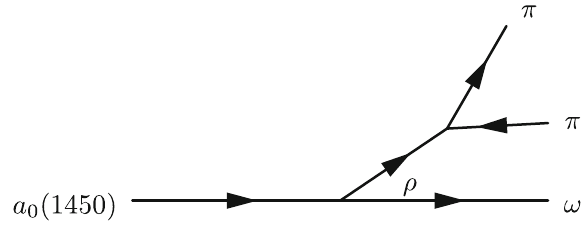
Fig. 5 Three body decay a 0 ( 1450 ) → ωππ